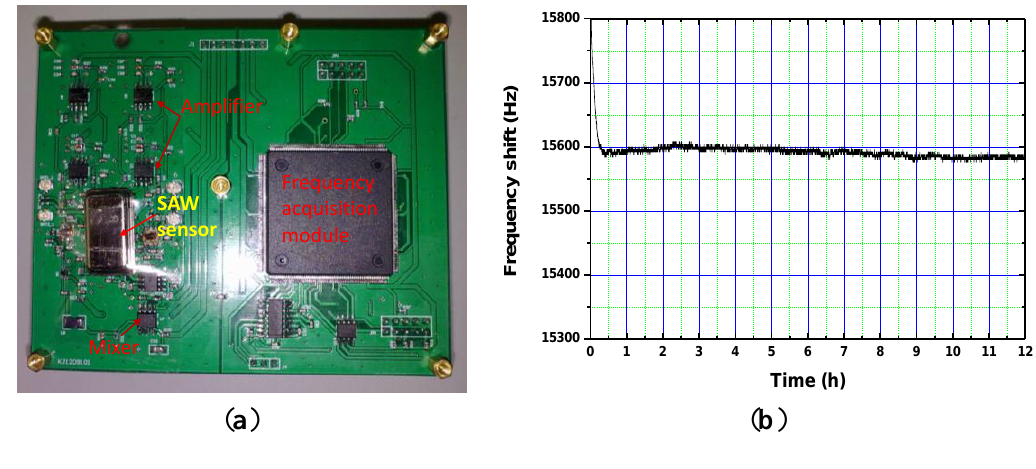
Figure 6. The fabricated SAW oscillator for rate sensor ( a ) and frequency stability measurement of the oscillator ( b ).